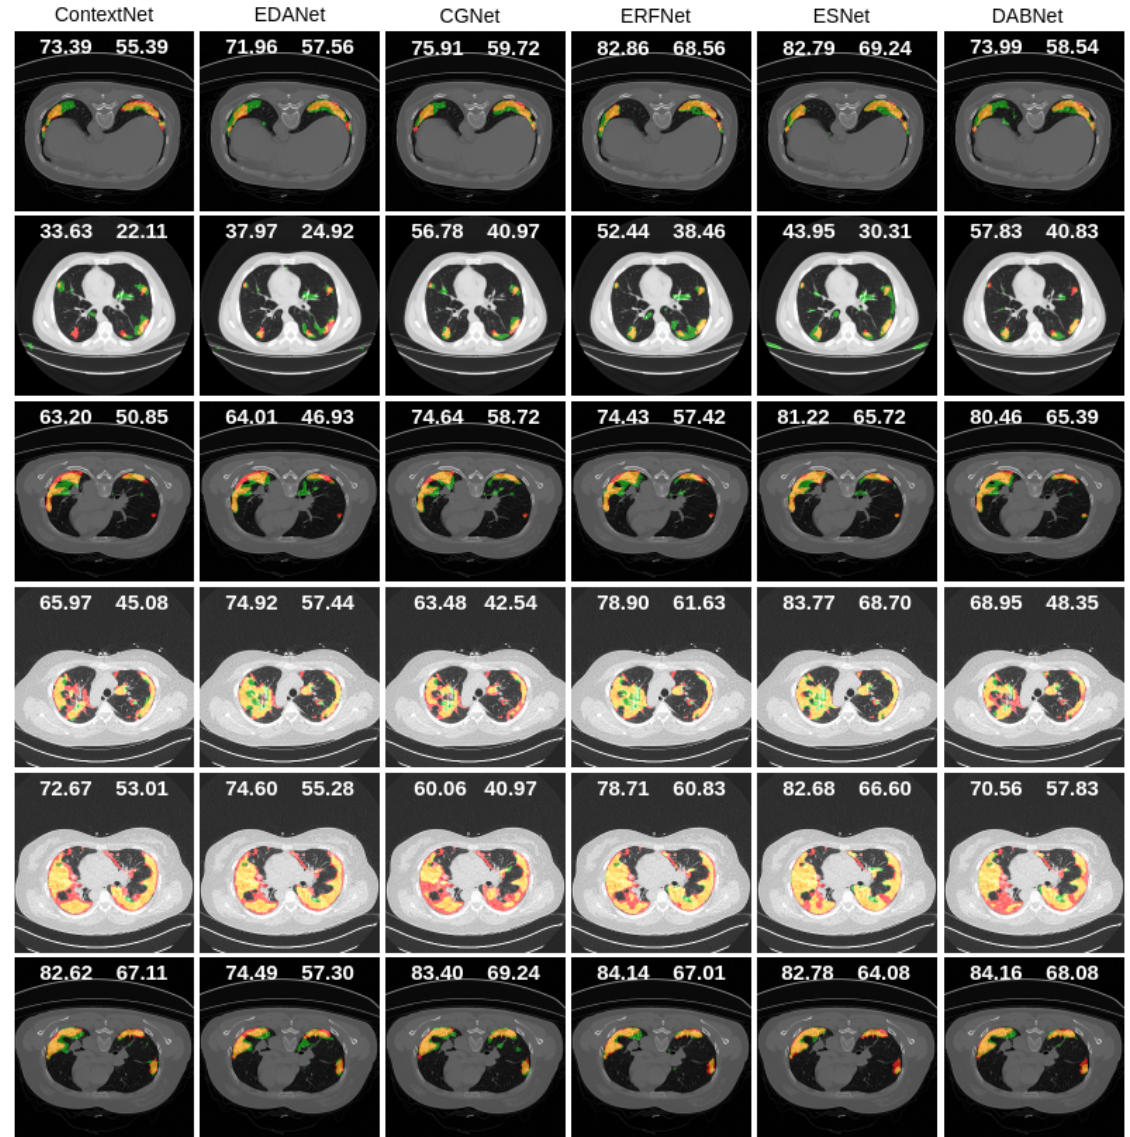
Figure 15. Qualitative comparison of the segmentation results of LungINFseg and six state-of-the-art segmentation methods (left to right: ContextNet–DABNet). Here, left and right side numbers on each example refer to dice and IoU scores, respectively. The colors are used to represent the segmentation results as follows: TP (orange), FP (green), FN (red), and TN